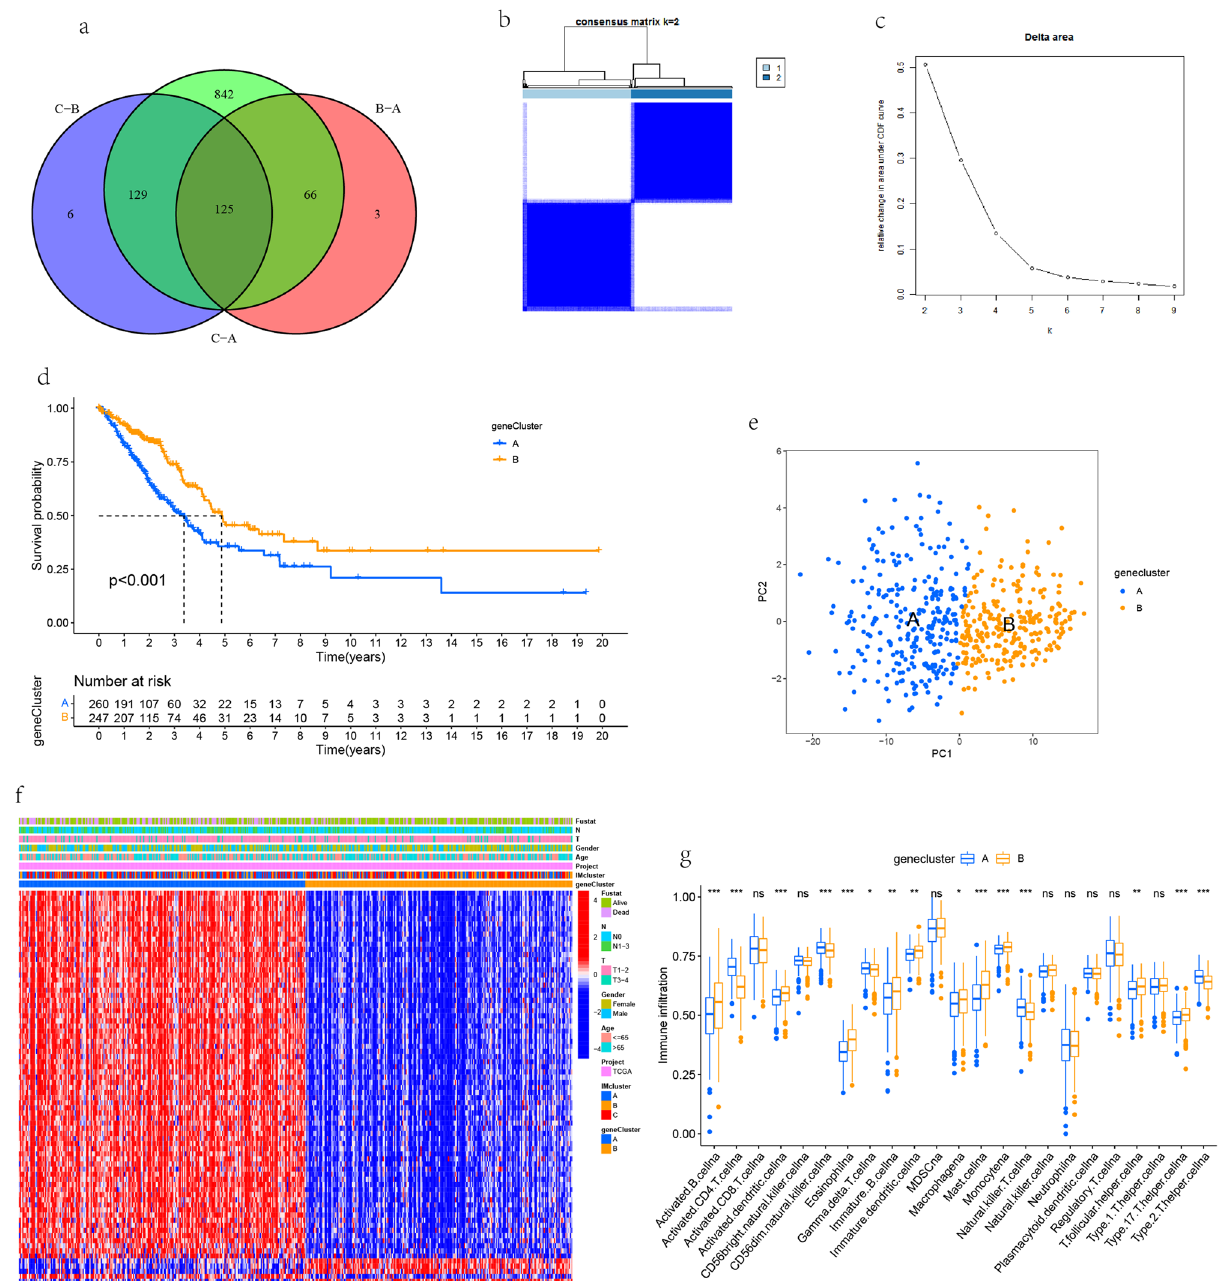
Figure 4. OS curve, clinical correlation and immune cell infiltration among geneclusters. ( a ) Venn diagram between the three clusters. ( b , c ) The genes were divided into two clusters according to the consensus clustering matrix (k = 2). ( d ) Kaplan Meier OS curve for two clusters. ( e ) Principal component analysis (PCA) shows the sample distribution of the two clusters. ( f ) The Heatmap showed the clinicopathological features of genes with different prognosis. ( g ) The degree of infiltration of immune cells between the two clusters. The pvalue was displayed as: ns: not significant * P < 0.05; ** P < 0.01; *** P <